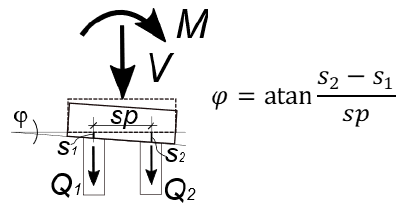
Figure 9. Diagram for calculating settlement and rotation of pile foundations. Q 1 , s 1 —load and settlement of pile 1; Q 2 , s 2 —load and settlement of pile 2; sp —axial spacing of the piles.